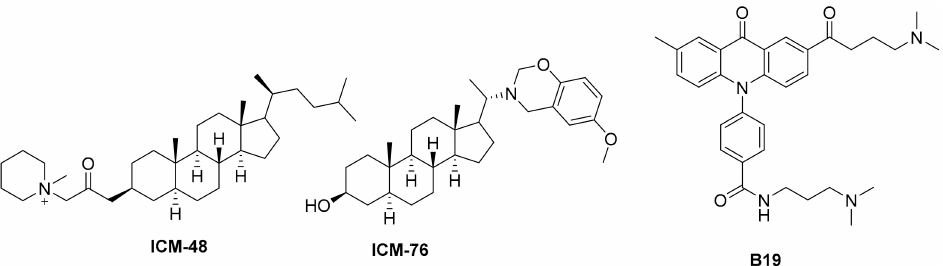
Figure 18. iM-interactive stroid derivatives ICM-48 and ICM-76, and acridone